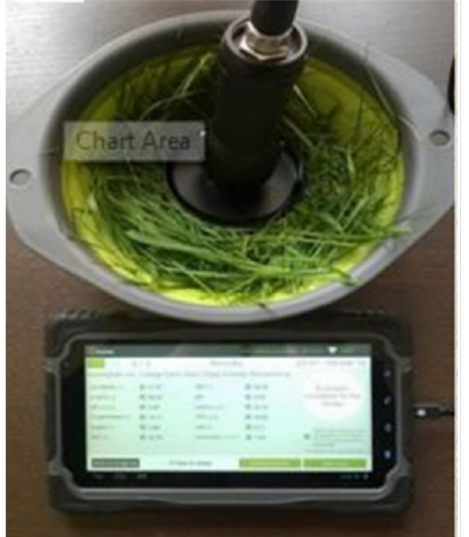
Figure 3. Image of NIR4 grass quality analysis system reprinted from ref.